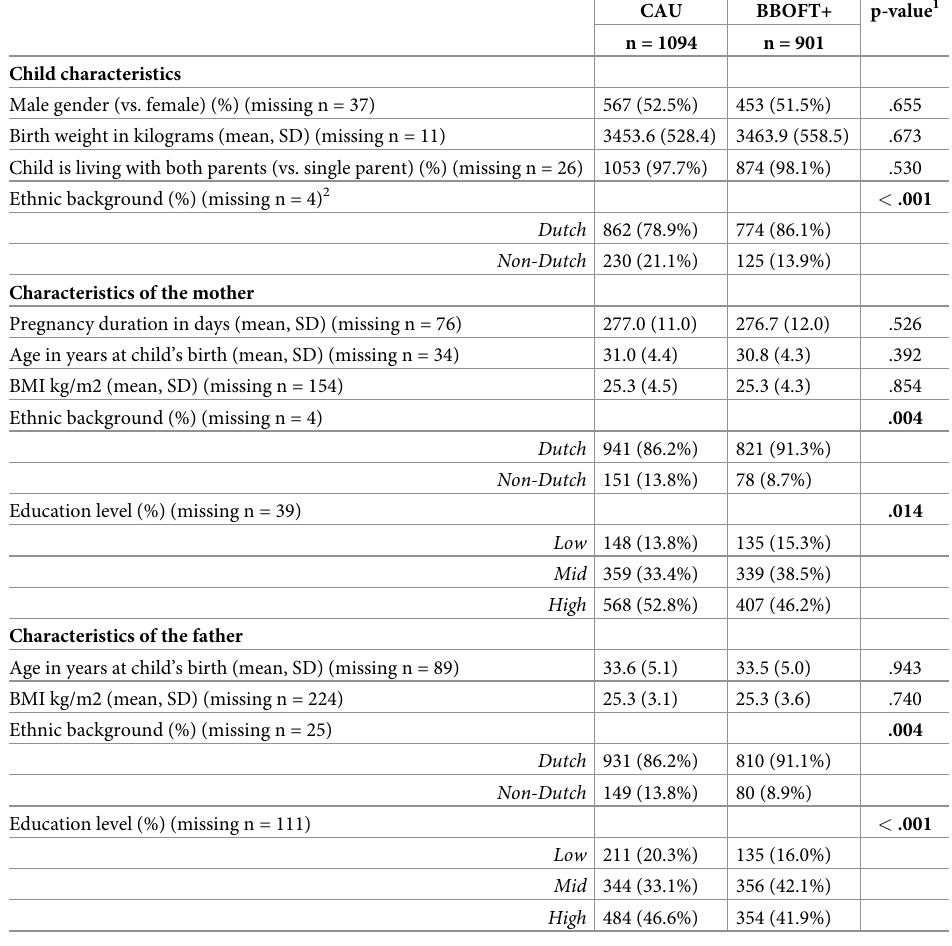
CAU BBOFT+ p-value 1